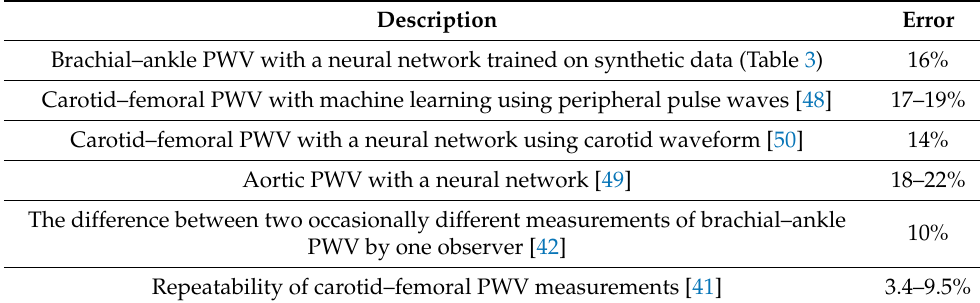
Table 2. Comparison of various errors in PWV estimation. Description Error